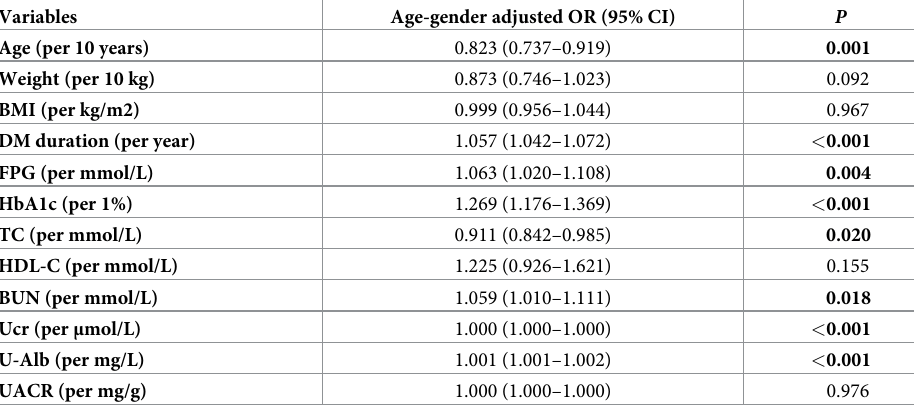
Next, for the risk factors screened out by multivariate logistic regression analysis, principal component analysis (PCA) was used to filter out the most prevalent risk factors associated Table 4. Risk factors of DR in the